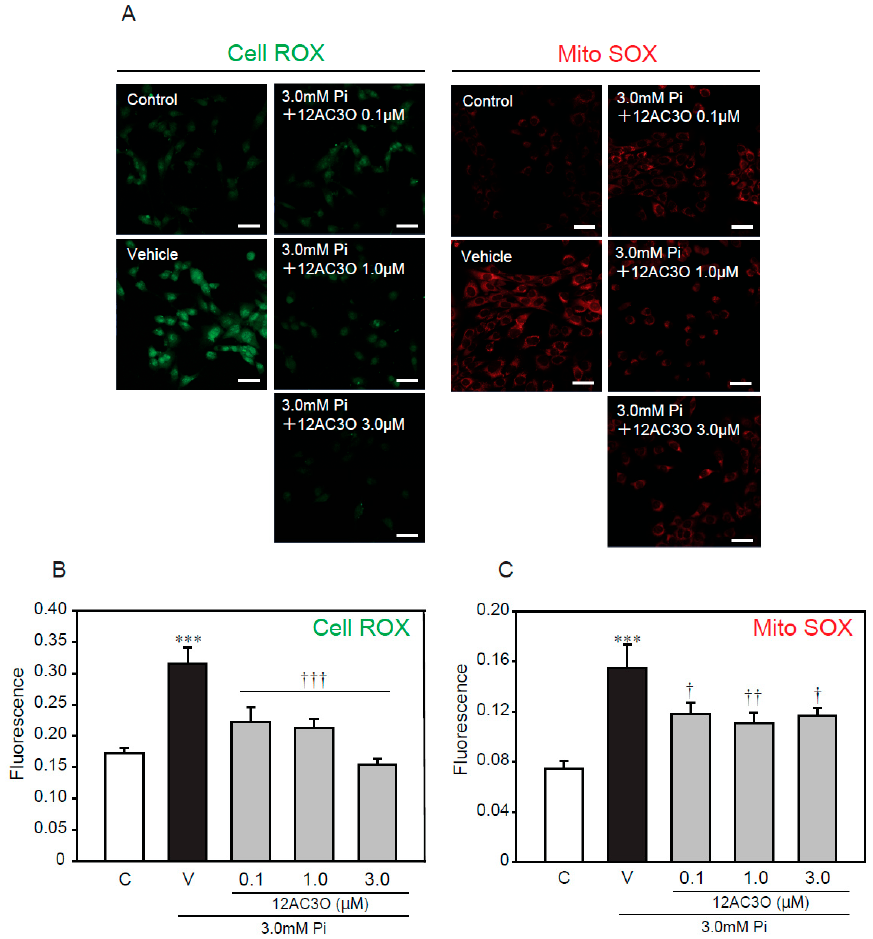
Figure 5. 12AC3O suppresses high concentration of Pi-induced oxidative stress. ( A – C ) p53LMAco1 cells were treated with 3.0 mM Pi and 12AC3O for 24 h. The relative fluorescence intensity of Cell ROX ( A , B ) and Mito SOX ( A , C ) was measured with Image J. Results are presented as the mean ± S.E.M of seven independent experiments based on the fluorescence intensity of the control. C: Control (1.0 mM Pi), V: Vehicle (3.0 mM Pi). *** p < 0.001 vs. Control, ††† p < 0.001, †† p < 0.01, † p < 0.05 vs. Vehicle. Scale bar: 100 μ m.